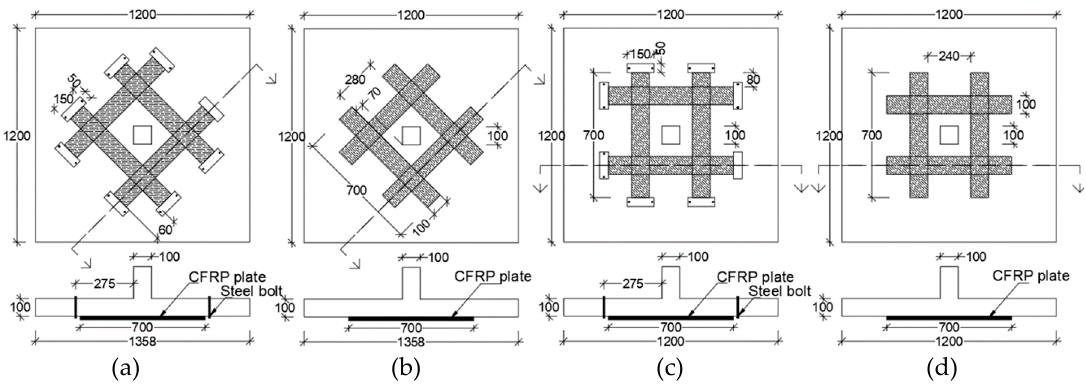
Figure 21. ( a ) Skewed CFRP strips with end anchorage, ( b ) skewed CFRP strips without end anchorage, ( c ) orthogonal CFRP strips with end anchorage, and ( d ) orthogonal CFRP strips without end anchorage [43].